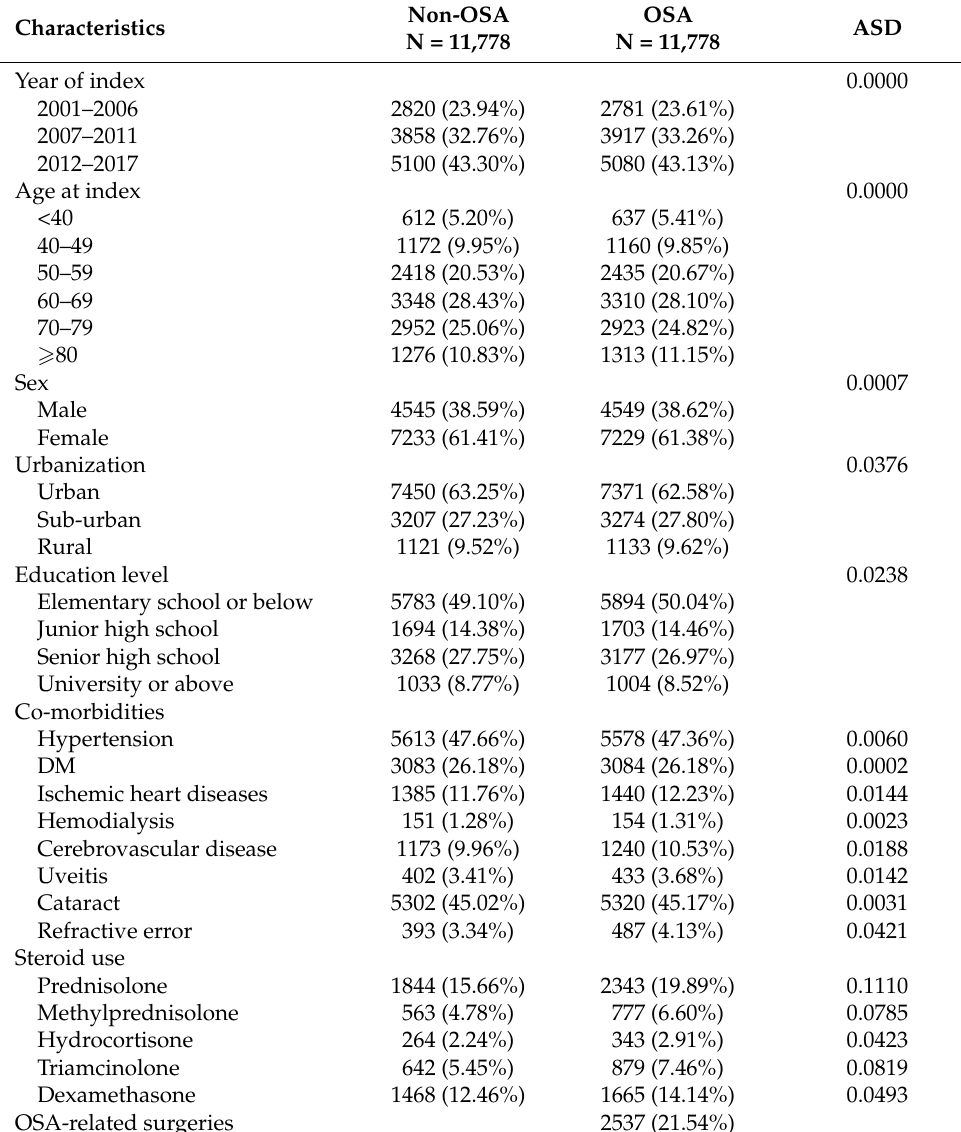
Table 1. Baseline characteristics among propensity score-matched population.